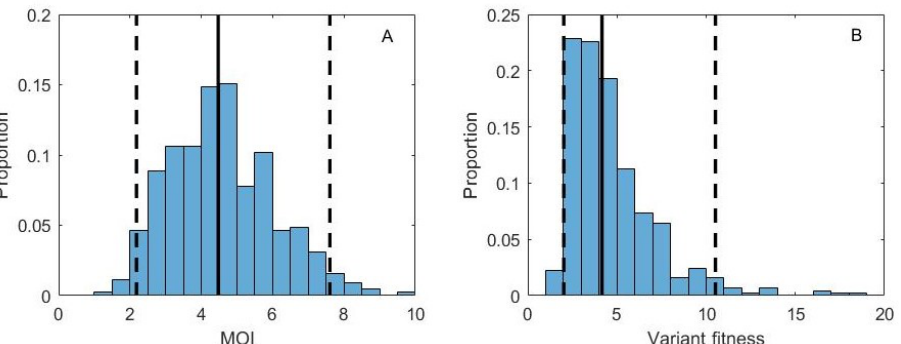
Figure 6. Fitness estimation for variant G788A, assuming stochastic within-host dynamics. ( A ) Posterior distribution for the mean cellular multiplicity of infection M . ( B ) Posterior distribution for variant fitness. In ( A , B ) the model was parameterized with an effective viral population size of N = 100. In ( A , B ) black solid lines show the median values of the posterior densities and black dashed lines show the 95% credible